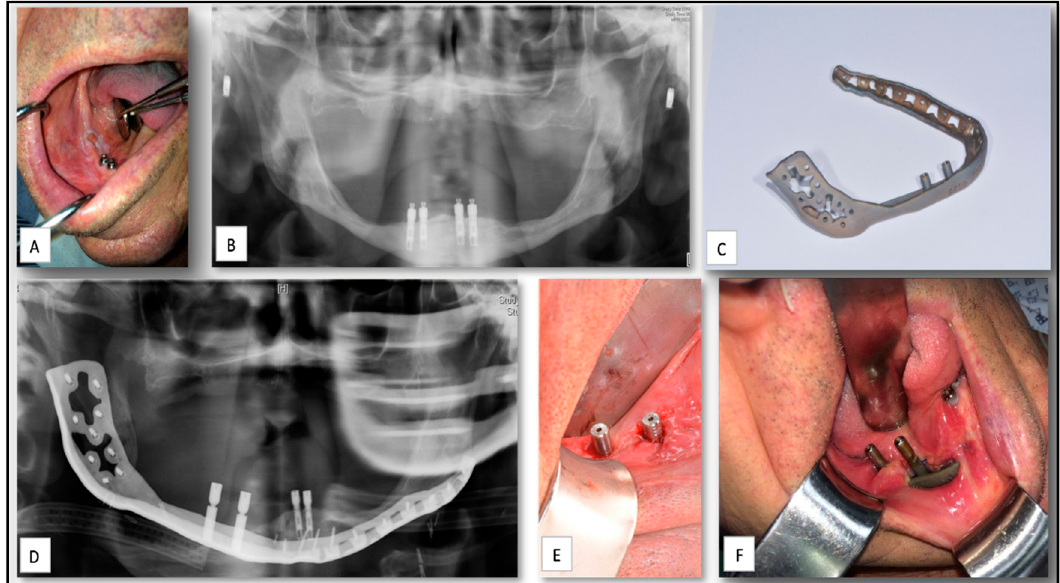
mandible. ( B) A pre-operative panoramic view of the mandible. ( C ) The 3D reconstruction implant